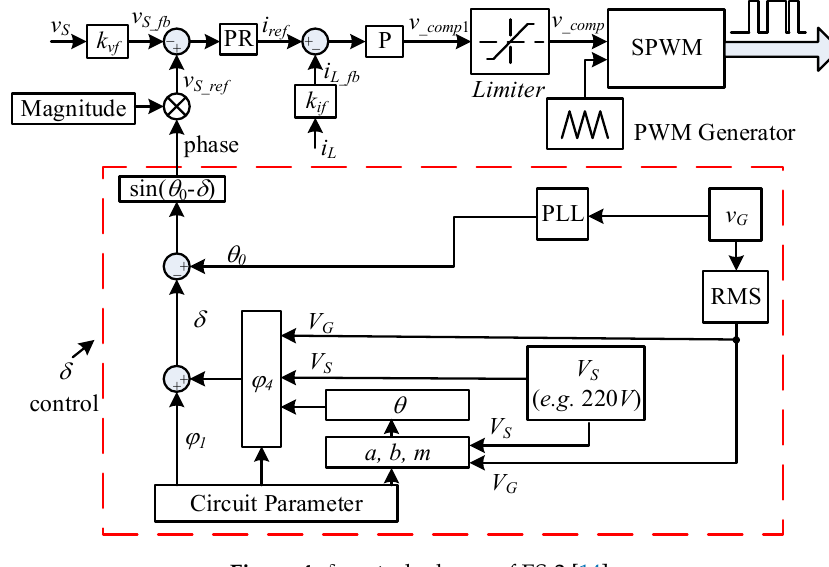
Figure 4. δ control scheme of ES-2 [14].